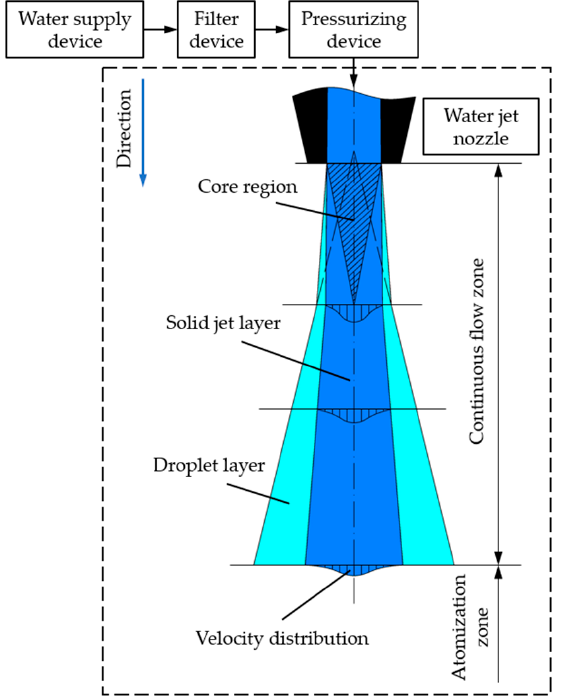
Figure 1. Schematic diagram of water jet cutting system and jet structure.